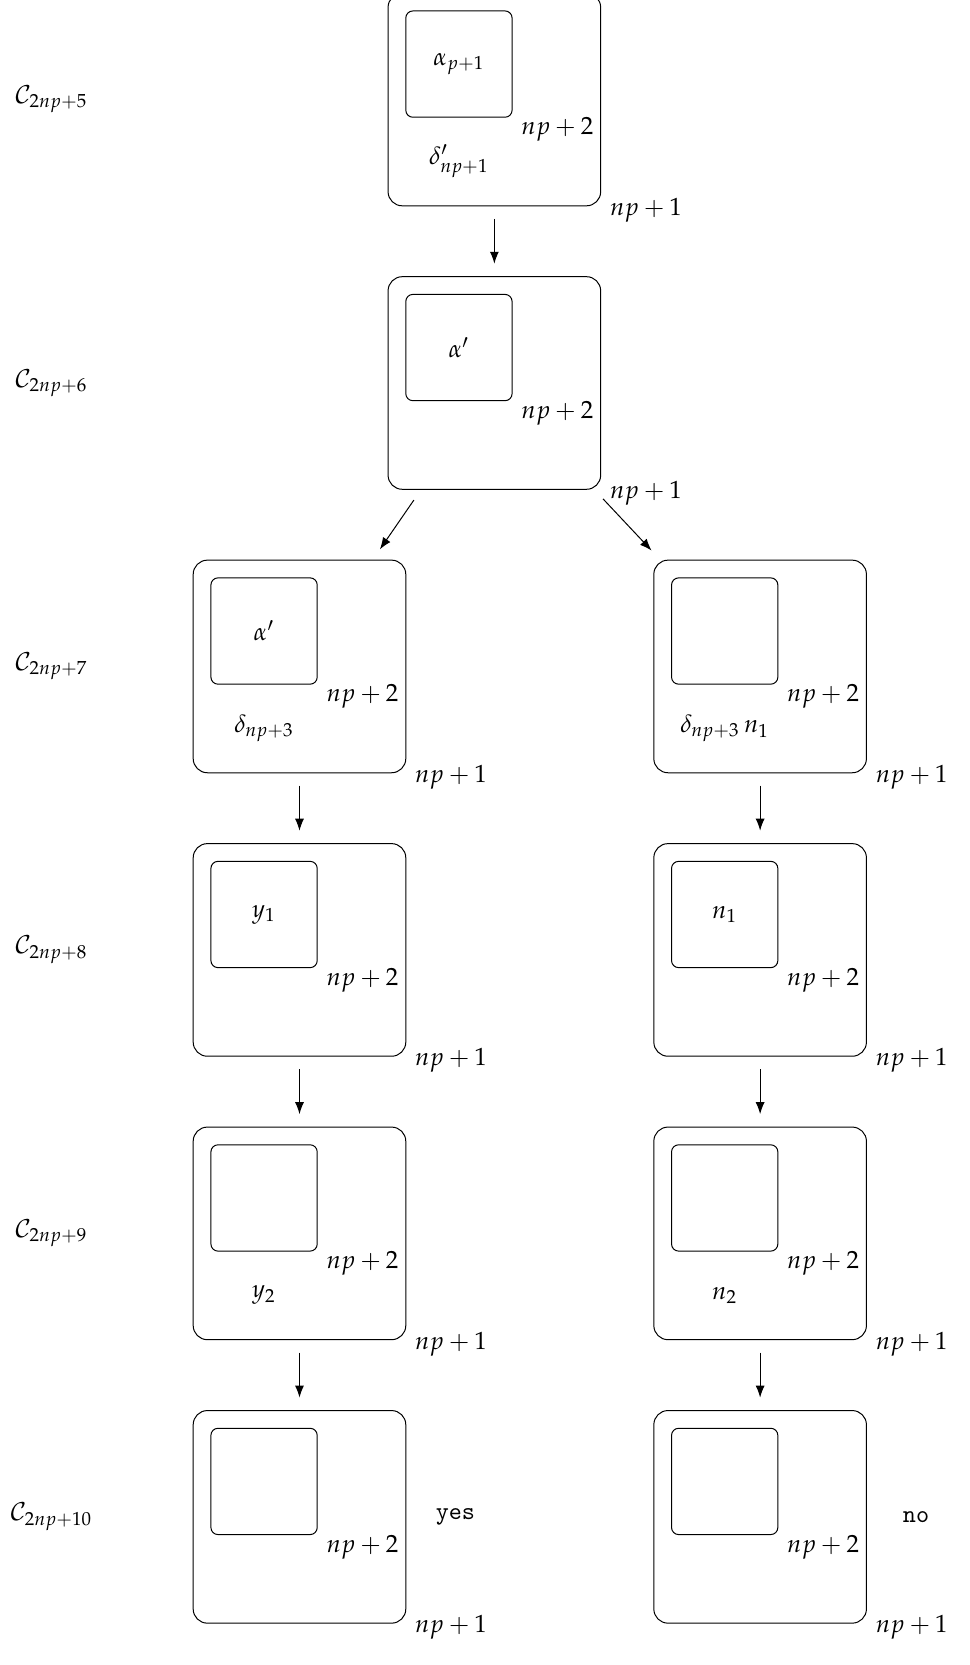
Figure 1. Evolution of the final stage in the affirmative case ( left ) and in the negative case ( right